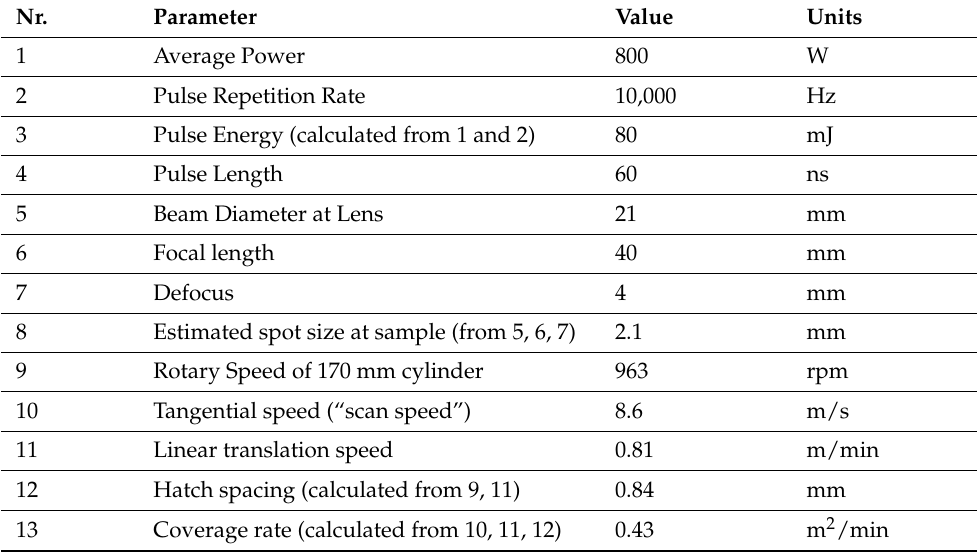
Table 2. Laser texturing parameters use for the CP aluminium texturing